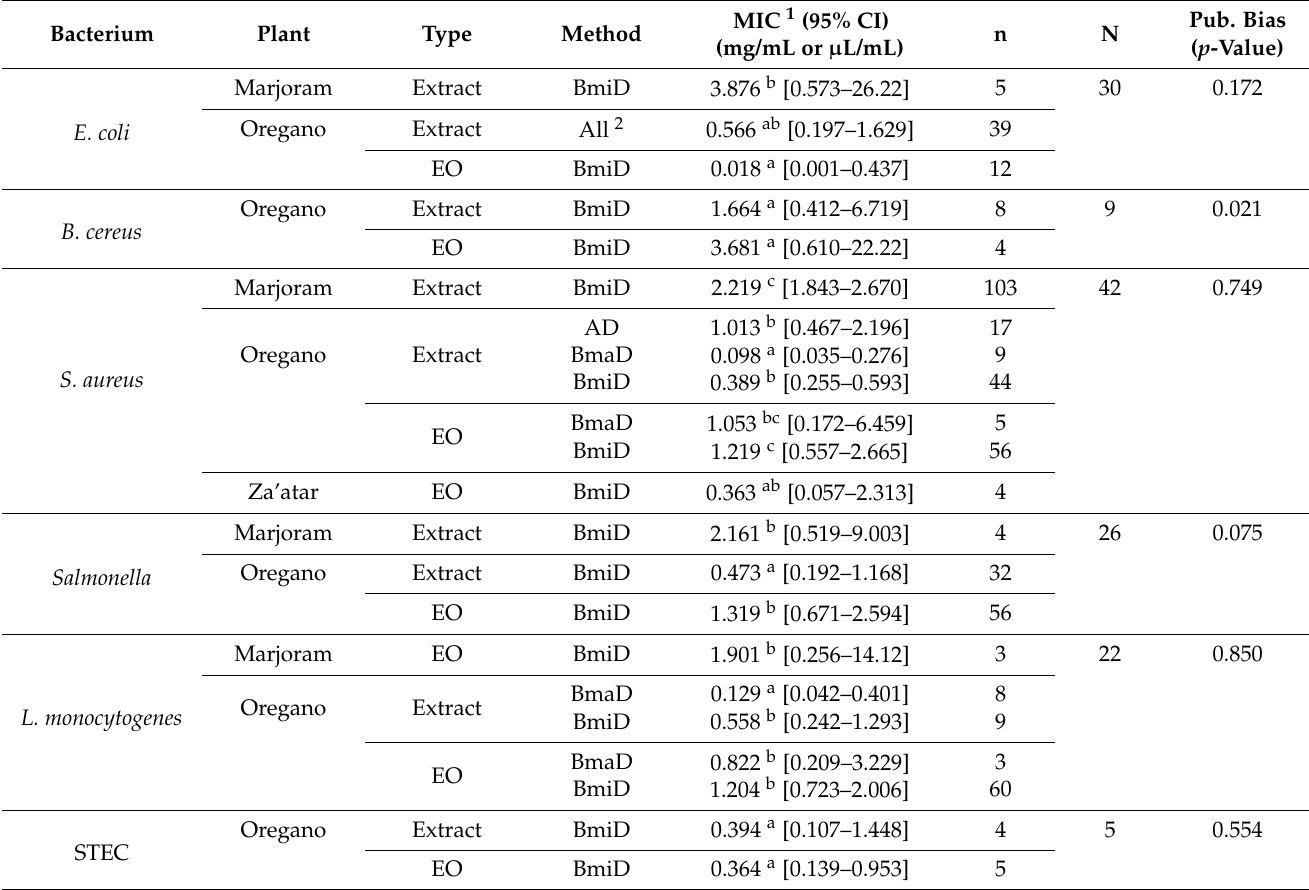
Table 5. Pooled MICs (mean and 95% confidence intervals, Cis) produced by extracts (in mg/mL) or EOs (in µ L/mL) of Origanum species by method of determination (agar dilution (AD), broth macro-dilution (BmaD) and broth micro-dilution (BmiD)), as estimated by meta-analysis models separately adjusted by bacterium. Number of observations (n), number of primary studies (N), and p -value of the publication bias test are displayed per meta-analysis